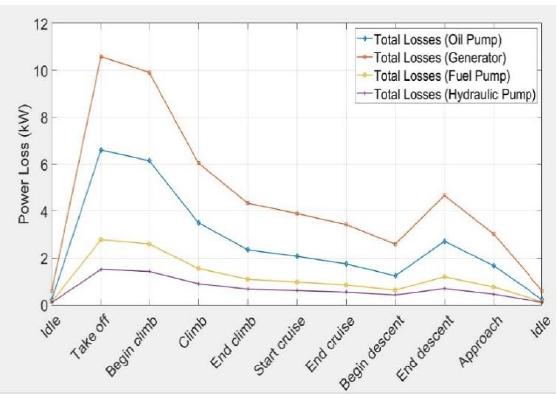
Figure 8. Total power loss for each element in AGB.